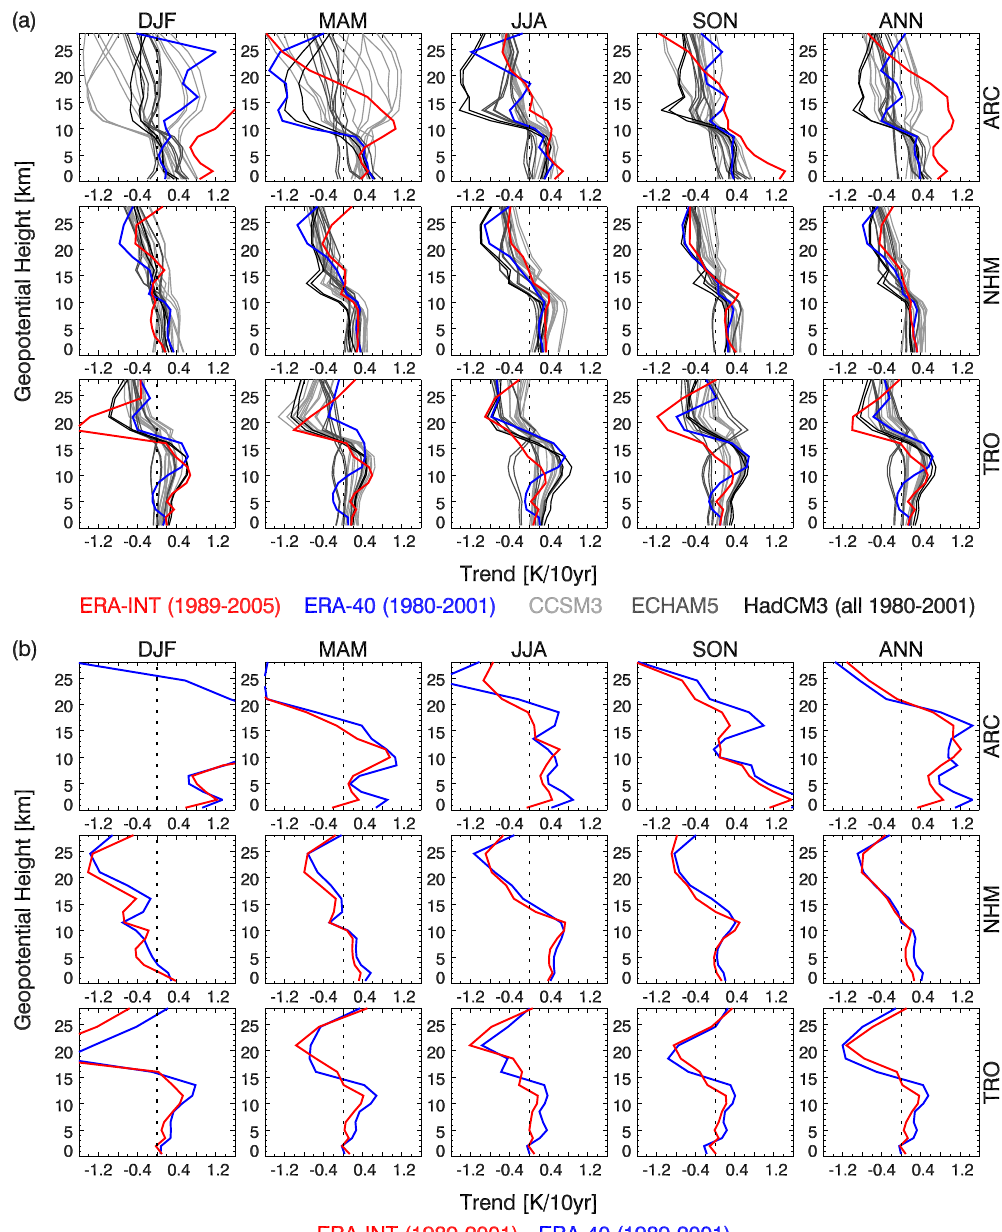
Fig. 6. 10-year temperature trends of seasonal and annual means in three selected zonal bands characterizing the high (ARC), middle (NHM) and low (TRO) latitudes. (a) ERA-INT trends in red (1989 to 2005), ERA-40 trends in blue (1980 to 2001), and GCM trends (1980 to 2001). The runs of the three models are marked in a different grey shade. (b) ERA-INT and ERA-40 trends for the period 1989 to 2001 for direct comparison of the